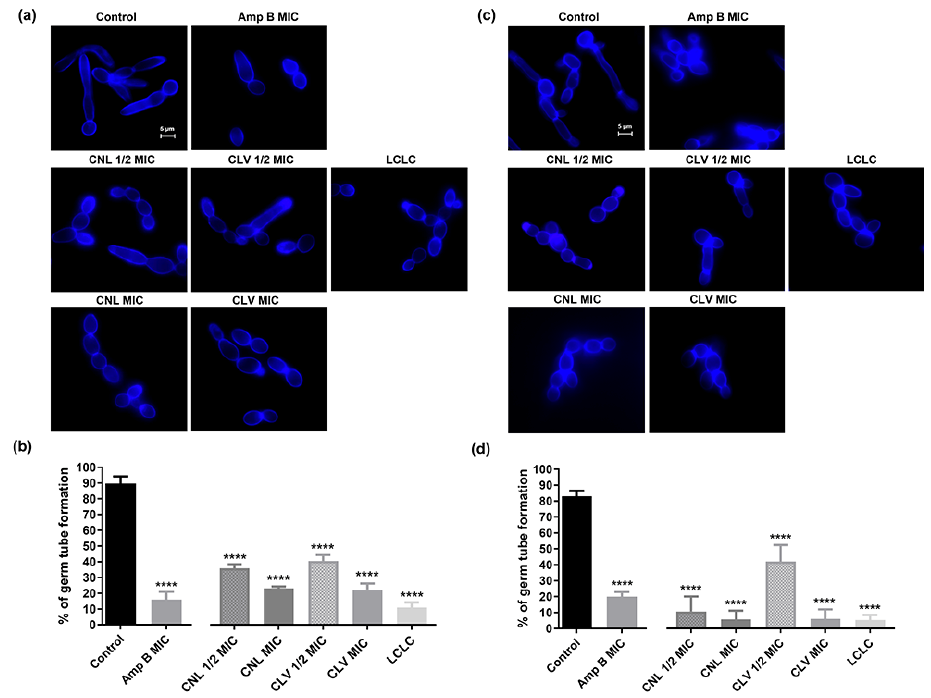
Figure 3. Effects of CNL, CLV, and Amp B on C. albicans germ tube formation. ( a , c ) Representative epifluorescence microscopy ( λ ex = 365 nm; λ em = 435 nm) images following exposure of ( a ) RSY150 and ( c ) ATCC 10231 to EOs and Amp B for 4 h. ( b , d ) Bar graphs show the quantitative analysis of ( b ) RSY150 and ( d ) ATCC 10231 germ tube formation for 300 cells from three biological replicates. EOs at all concentrations tested significantly (****, p < 0.0001) inhibited the yeast-to-hyphal transi- tion.